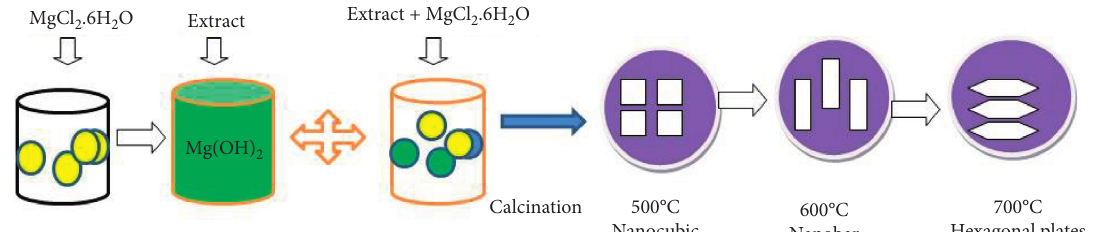
Figure 3: Mechanism of synthesis of MgO nanoparticles.